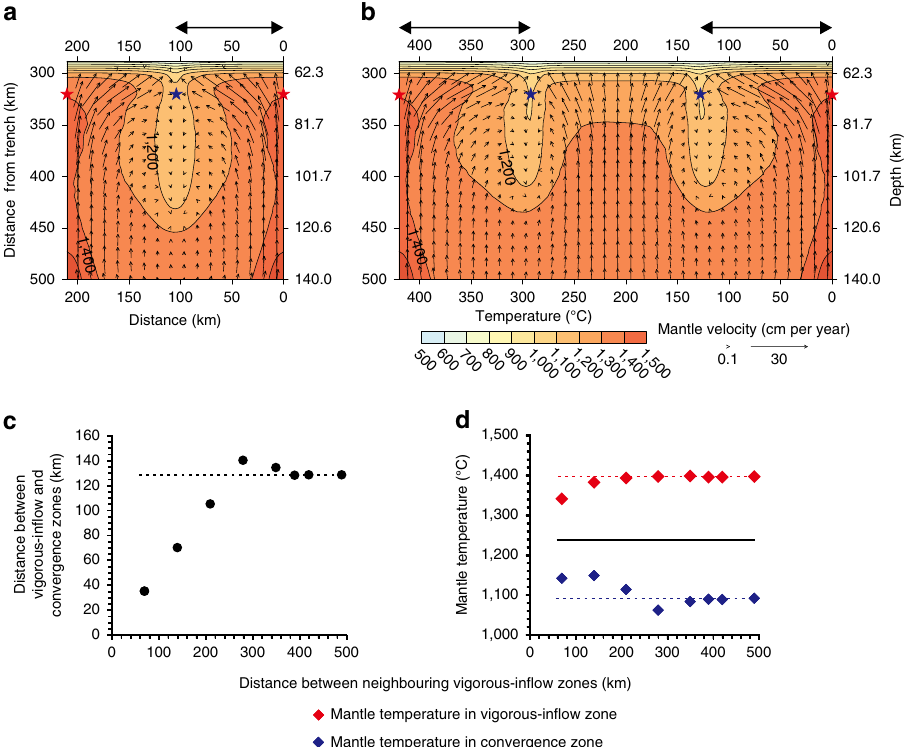
Figure 2 | Temperature and mantle flow fields calculated from models with two back-arc high-temperature anomalies. ( a and b ) Temperature distribution (colour) and mantle flow field (black vectors) on the dipping plane (indicated by the red dashed plane in Fig. 1a) calculated from models with two high-temperature anomalies that are separated by a distance of 210 and 420km, respectively. The temperature contours are at every 100 (cid:2) C. Red and blue stars indicate the probe locations for mantle temperature in the vigorous-inflow and convergence zones, respectively, shown in d . Double-arrow- headed lines at the top indicate the distance between the vigorous-inflow and convergence zones. ( c ) Change in the distance between the vigorous-inflow zone (red stars in a and b ) and the convergence zone (blue stars in a and b ) with the distance between the two vigorous-inflow zones (i.e., the two red stars). Black dashed line indicates the characteristic distance (128.3km) from the reference model. ( d ) The sub-arc mantle temperature at the tip of the vigorous-inflow zones (red diamonds) and convergence zones (blue diamonds). Black line indicates the mantle temperature from the model without the high-temperature anomaly. Red and blue dashed lines indicate the mantle temperatures of the vigorous-inflow and convergence zones, respectively, from the reference